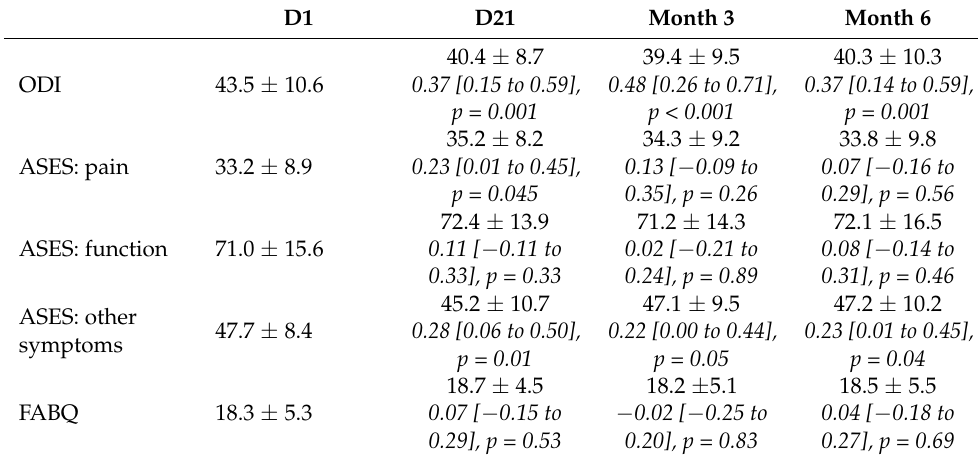
Table 1. Change in Oswestry Disability Index, ASES, and FABQ scores over time.